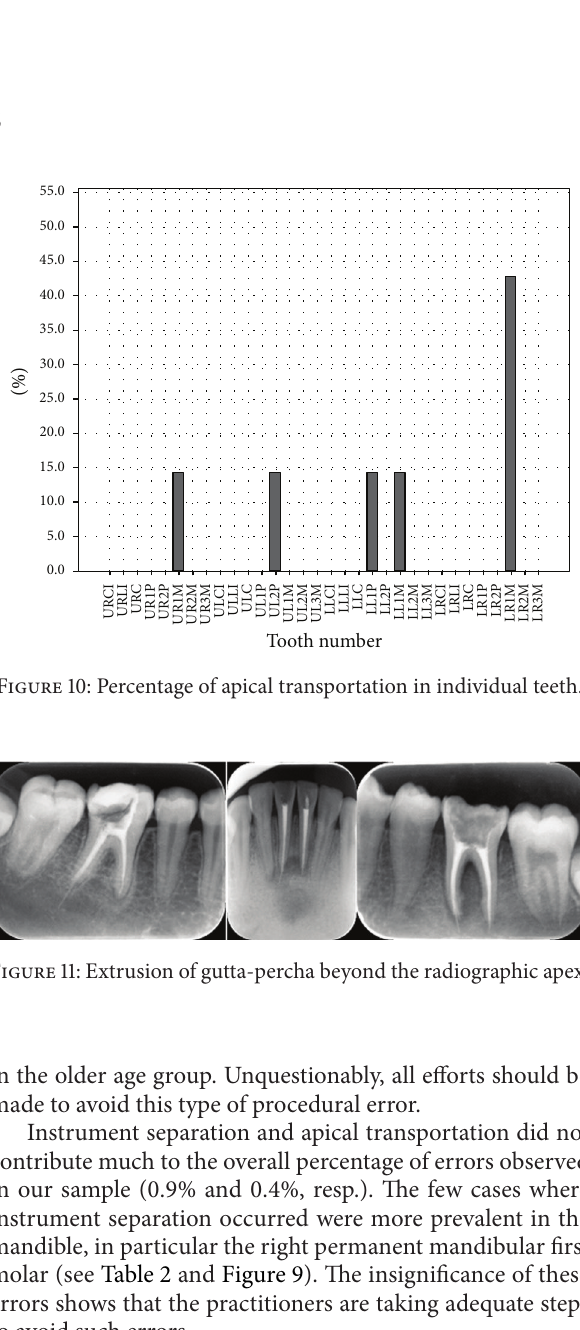
in the older age group. Unquestionably, all efforts should be made to avoid this type of procedural error.